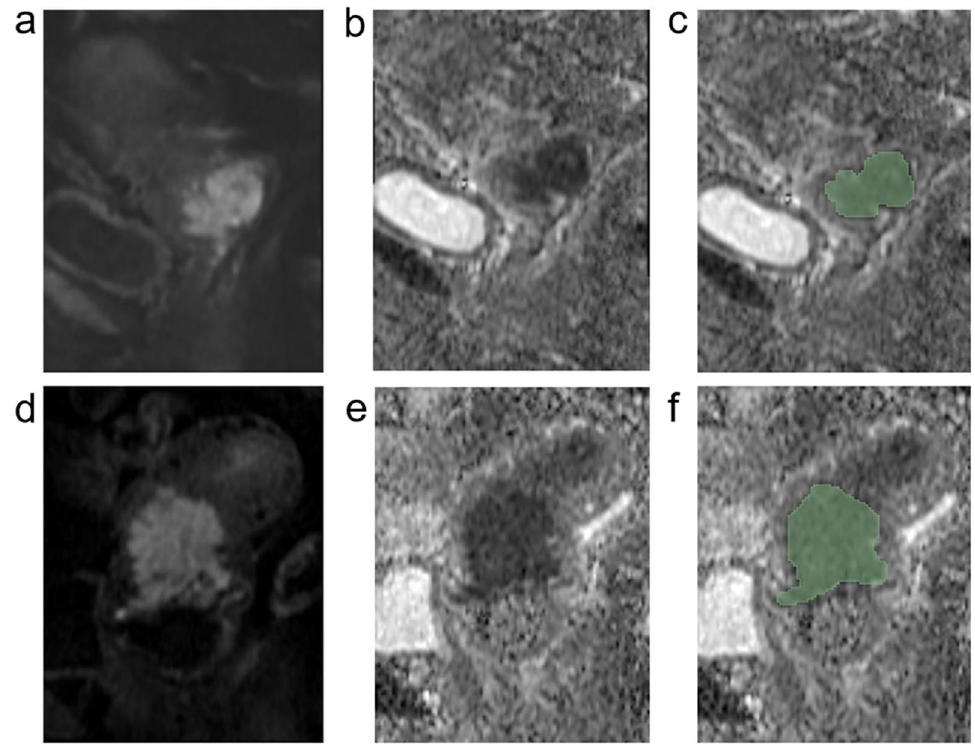
Fig. 2 A patient with FIGO stage IB cervical cancer (upper row) and a patient with FIGO stage IV cervical cancer (lower row) . The high signal intensity on sagittal rFOV DWI with b value of 800 s/mm 2 ( a and d ) and the low signal intensity on the corresponding ADC maps ( b and e ) illustrate the areas of tumors. The green areas on the ADC maps ( c and f ) represent the tumor regions of